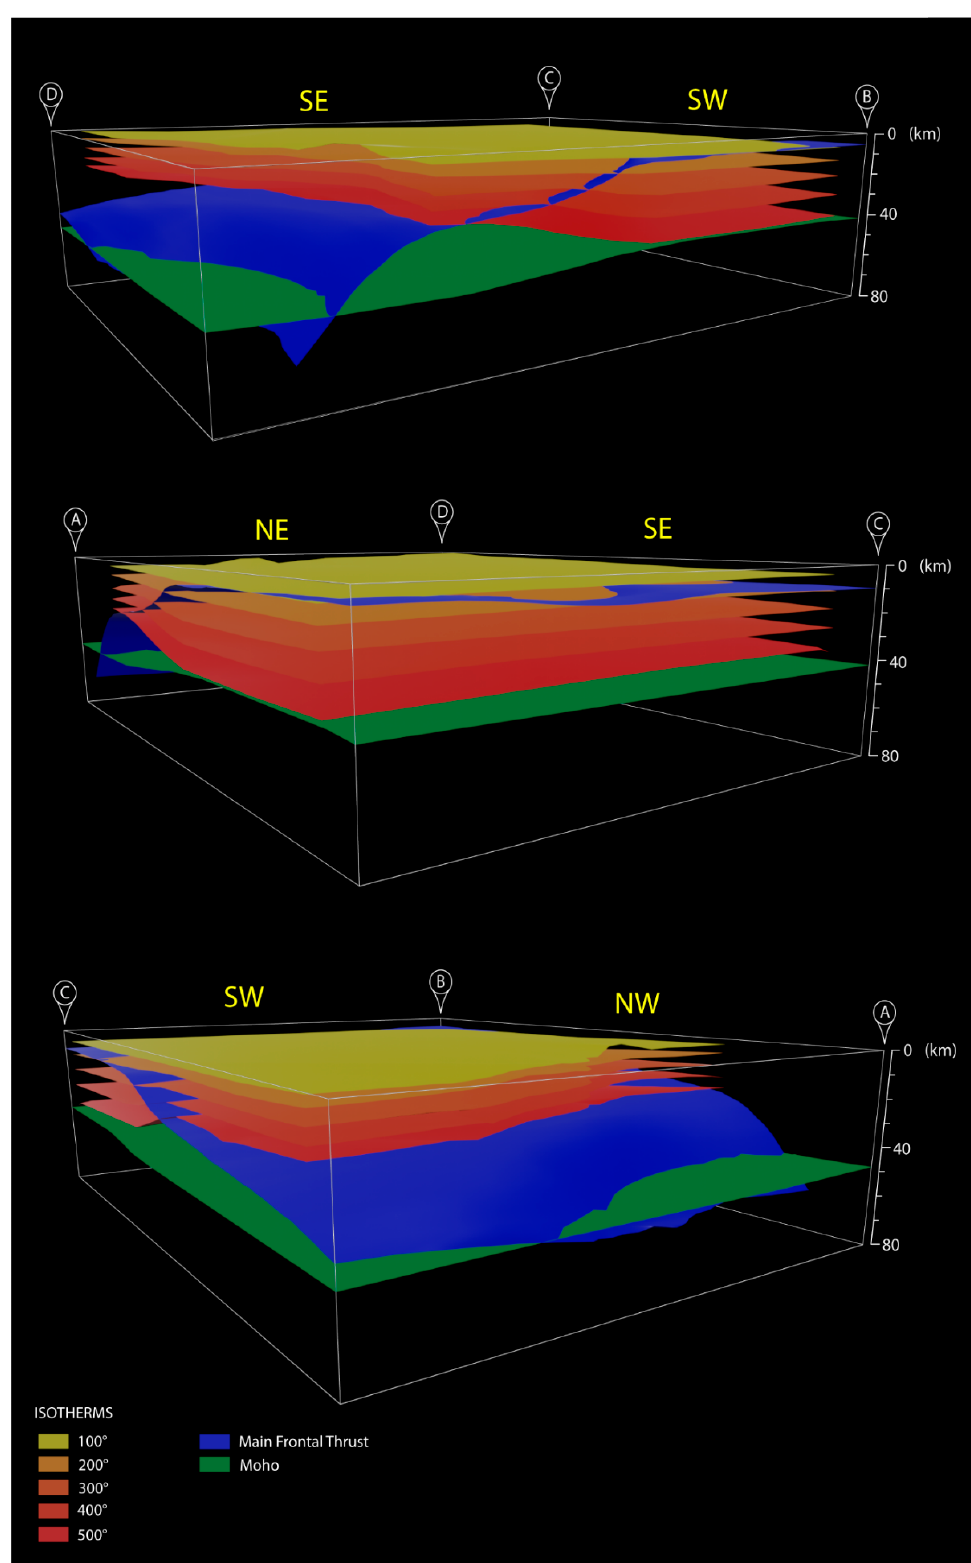
Figure 10. Three different views of the 3-D thermal model obtained for the study crustal volume of the Lurestan arc. The model shows isotherms obtained with spline interpolation for the 100–500 °C temperature range (100 °C steps), together with the MFT and the Moho discontinuity, this latter obtained from Jiménez-Munt et al. [15].